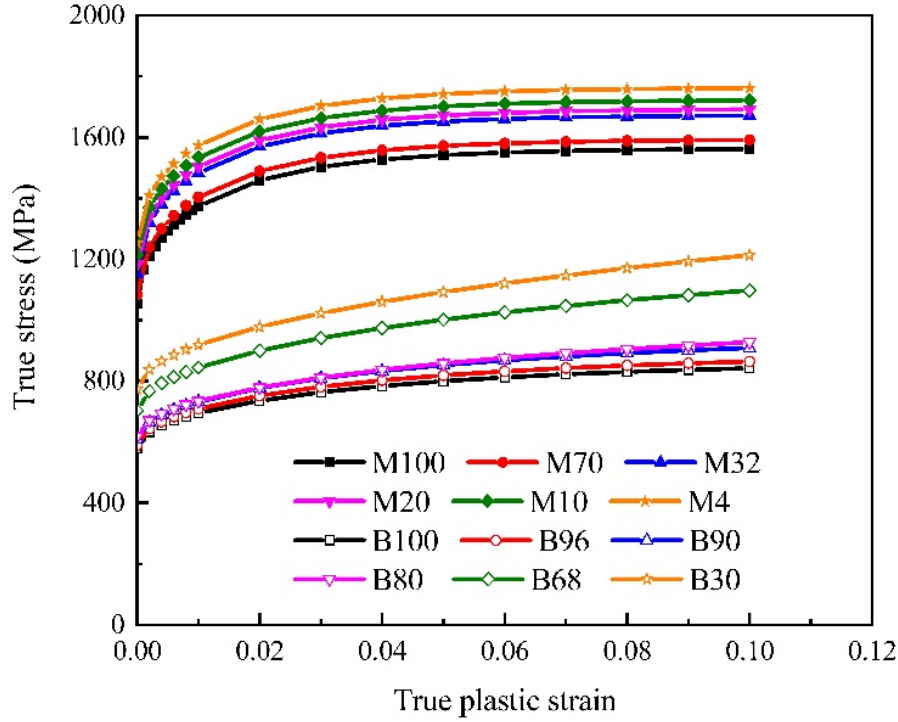
Figure 8. Flow curve predictions of the specimens with varying B/M phase volume fractions.